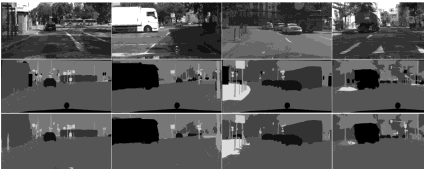
Figure 4. Front-end+Large network’s image segmentation results for shadowed and unshadowed